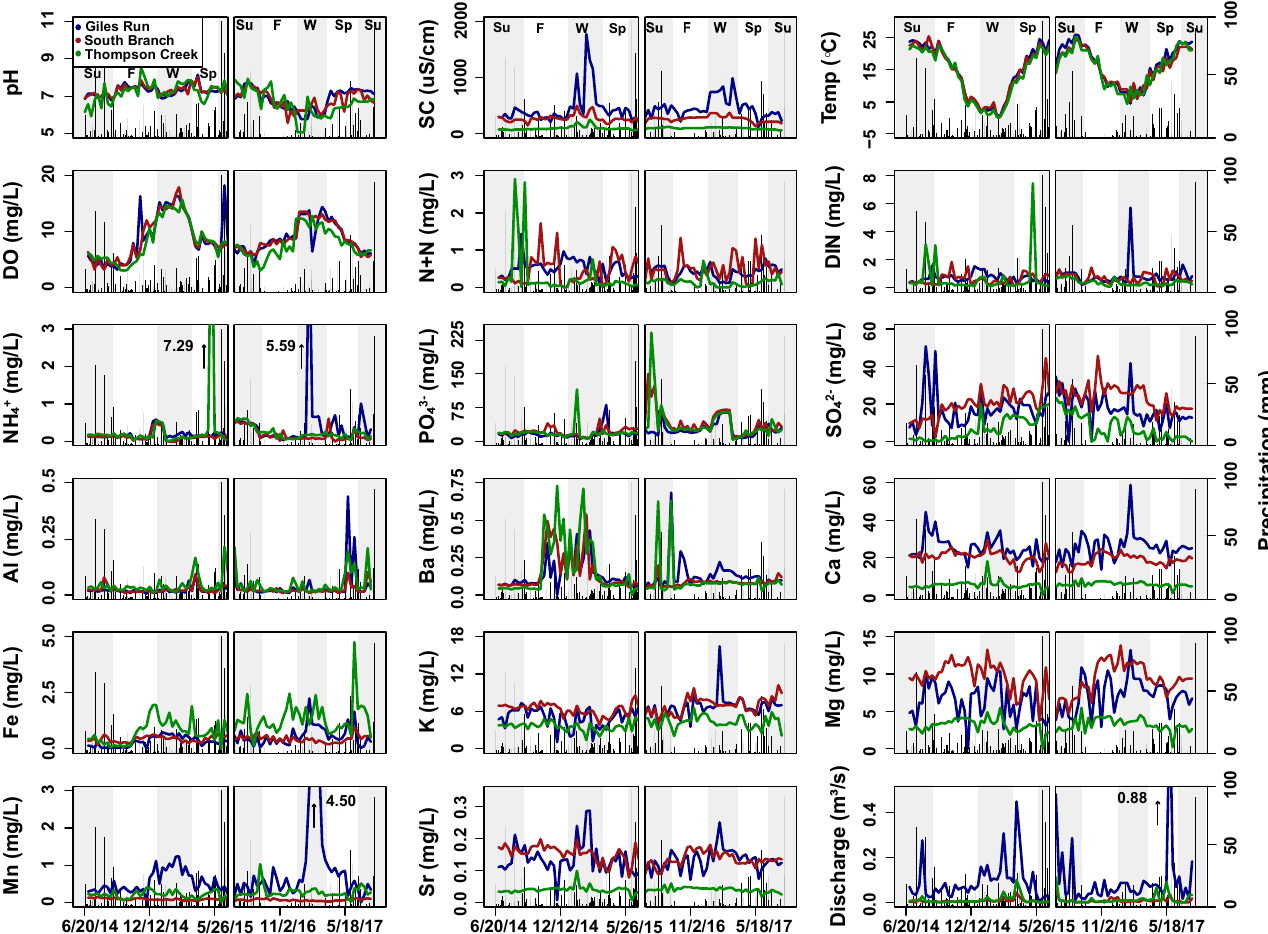
Figure 2. Time series plots of selected surface water variables for Giles Run (blue), South Branch (red), and Thompson Creek (green) over the two sampling periods (June 2014–July 2015 and May 2016–July 2017). Daily precipitation values are shown as black bars. The gap within each panel indicates the break between sampling periods. Alternating grey and white bars indicate the seasons: summer (Su), fall (F), winter (W), and spring (Sp). High outliers with values greater than the upper limit of the y axis are shown with an up arrow and the numerical value on the graph.